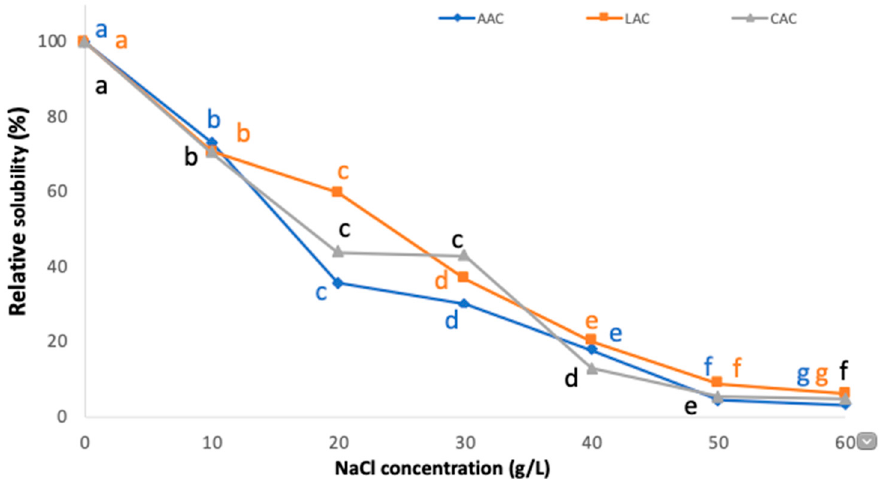
Figure 4. Effect of solubility of needlefish skin collagens extracted with different acids at different concentration of NaCl. AAC: acetic acid collagen; LAC: lactic acid collagen; CAC: citric acid collagen. Different letters indicated significant differences between the samples.